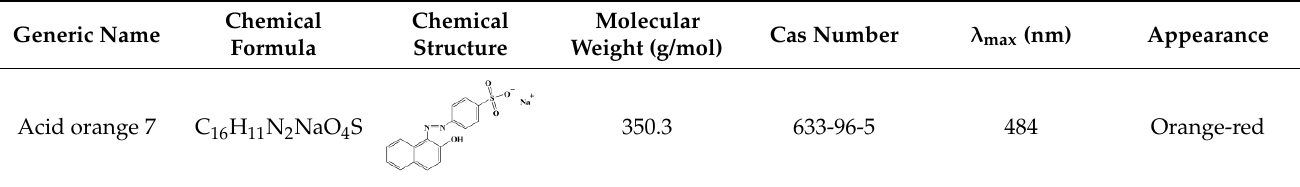
Table 1. General characteristics of AO7 dye.